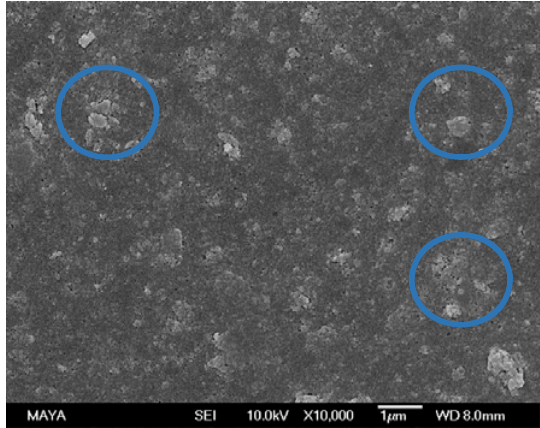
Figure 5. SEM image of a membrane sample after final cleaning in the long-term study. Objects assignment: assumingly extractives (circle in blue).